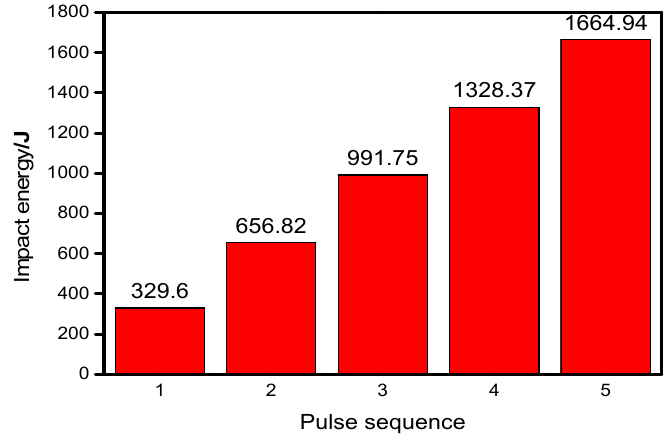
Figure 15. Current and voltage waveforms under five pulses.